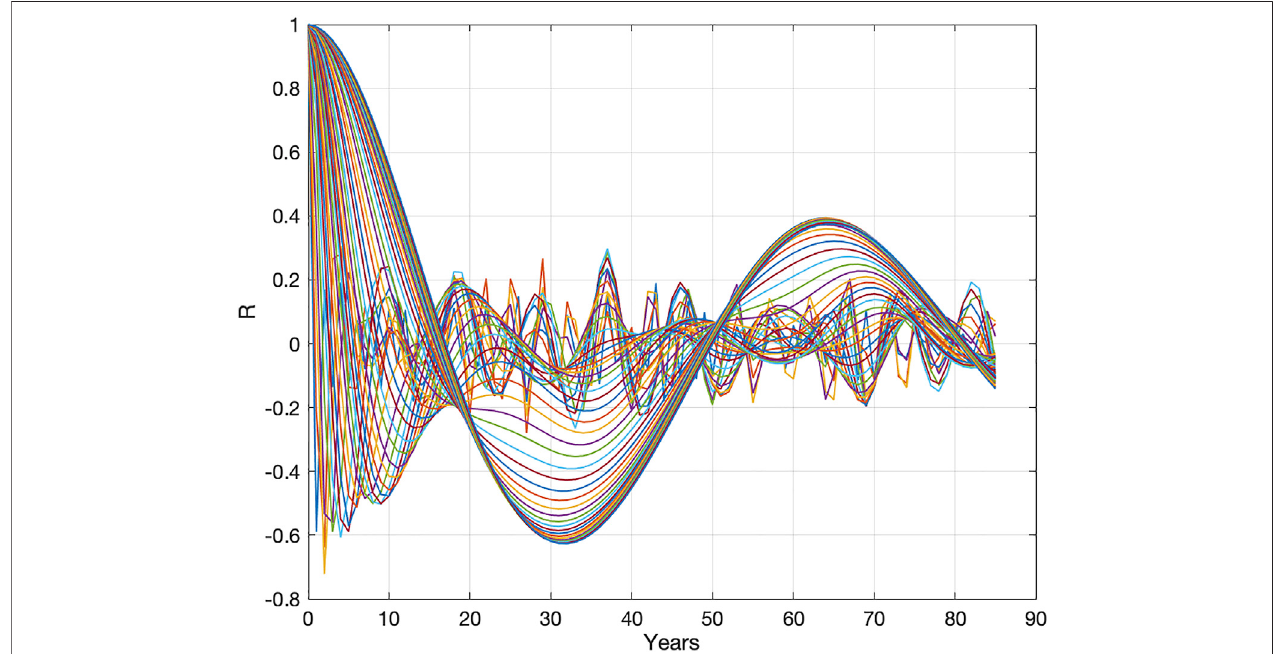
FIGURE 4 | Global sea surface temperature wavelet autocorrelations: WRgst (Rgst(s), m) for s = (1 ... 85) and m = (0 ... 85) (yr.).